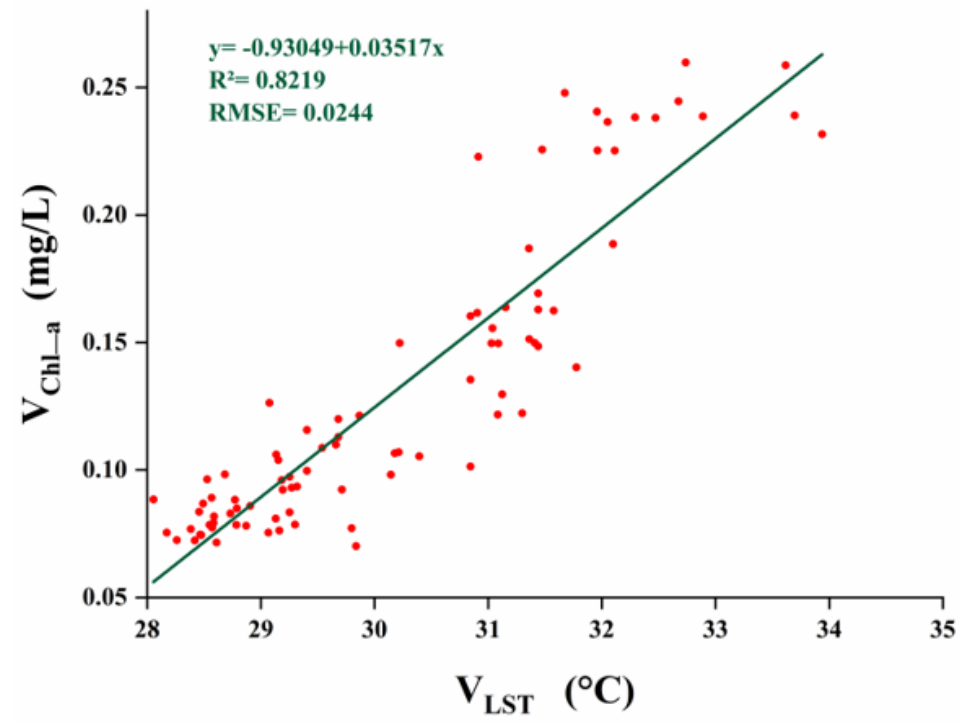
Figure 6. Linear correlation between the CCAPL and the STPL.